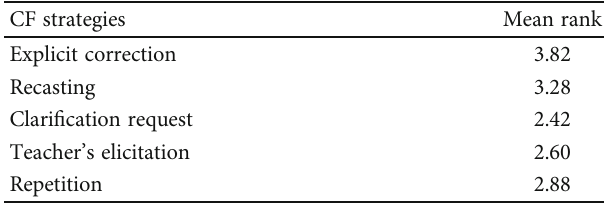
Table 3: The ranks of CF strategies preferred by the students.